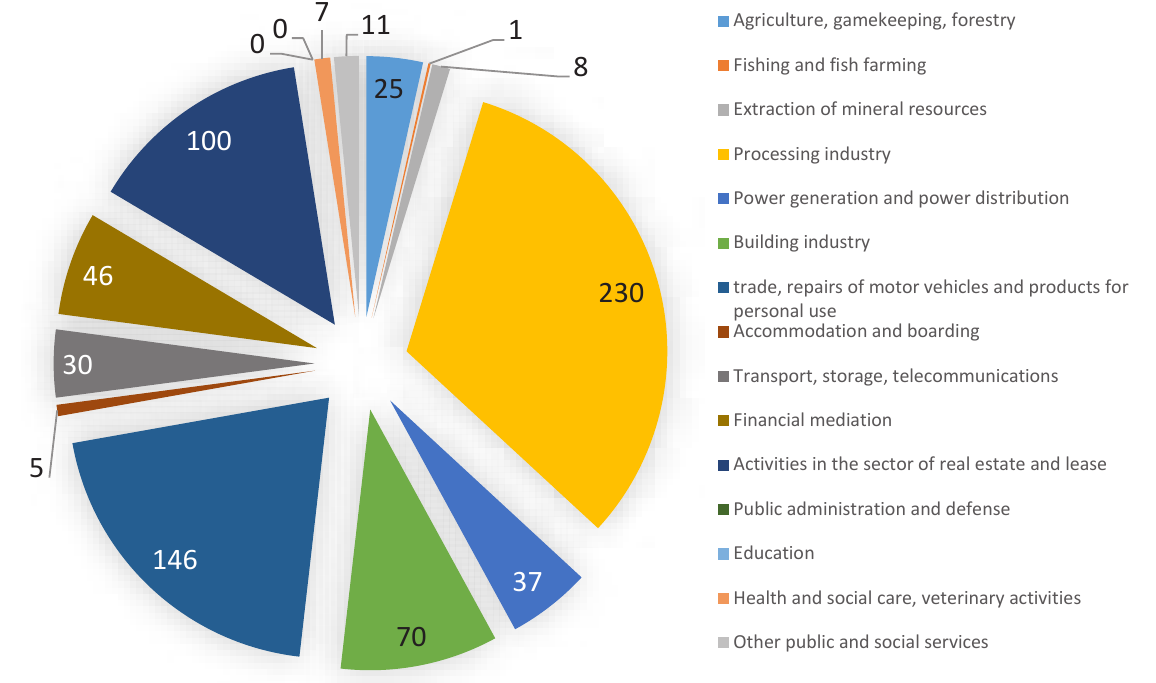
Figure 1. Distribution of consolidated economic entities per industries